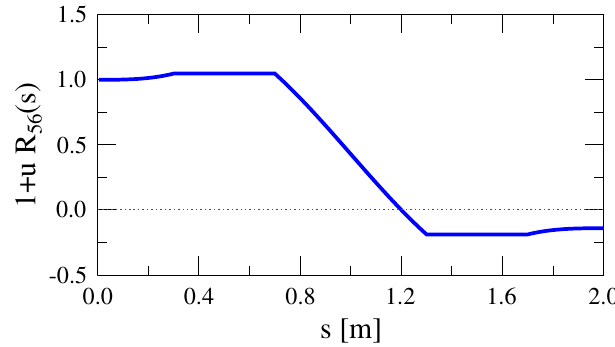
(cid:3) s (cid:5) (cid:1) 1 (cid:2) uR 55